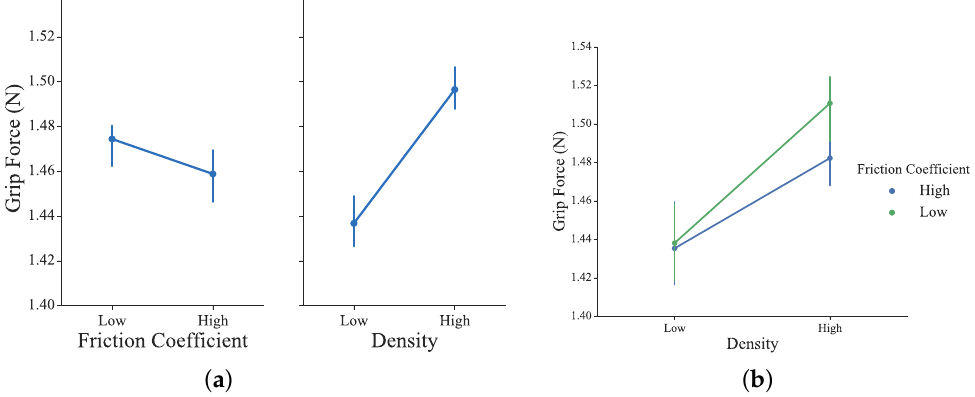
Figure 11. ( a ) Mean grip force of all subjects under four experimental conditions; ( b ) Mean grip force of all subjects across all conditions in the factor